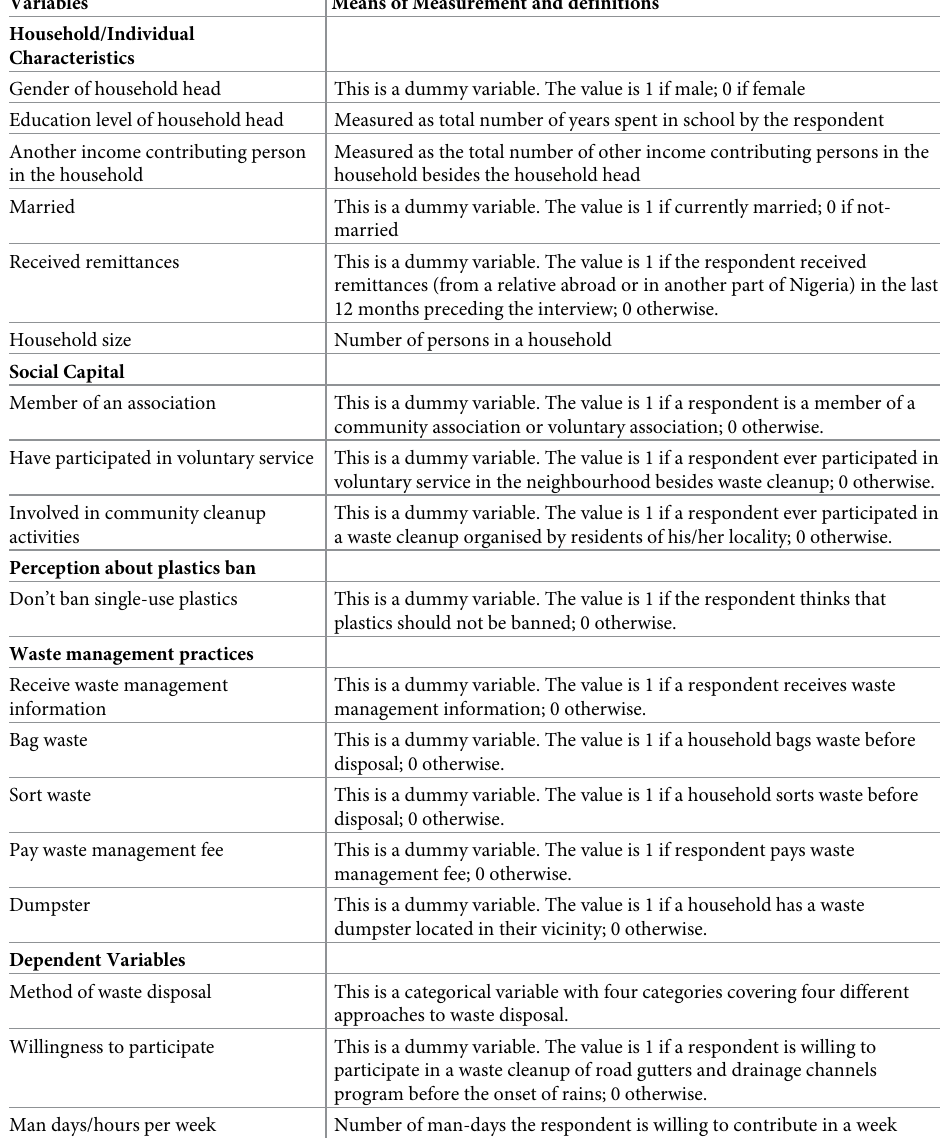
Table 1. Definition of explanatory variables used in the